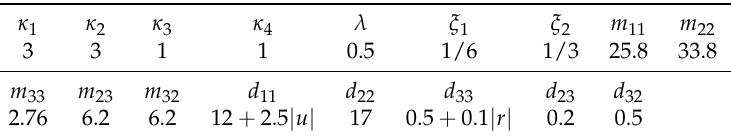
Table 1. Damping and inertial coefficients of the underactuated surface vessels (USV) [26] and the parameters in controller.